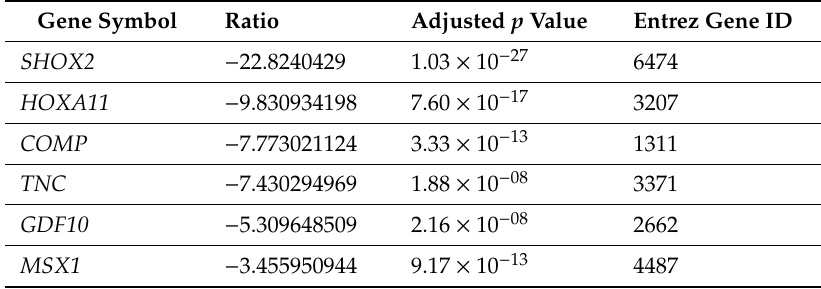
Figure 1. Heat map representation of differentially expressed genes belonging to “endochondral bone morphogenesis”, “ossification” and “skeletal system development” gene ontology biological process (GO BP) terms. Arbitrary signal intensity acquired from microarray analysis is represented by colors (green, higher; red, lower expression). Log2 signal intensity values for any single gene were resized to row Z-score scale (from –2, the lowest expression, to + 2, the highest expression for a single gene). Table 1. Gene symbols, fold changes in expression, Entrez gene IDs, and corrected p -values of studied genes.